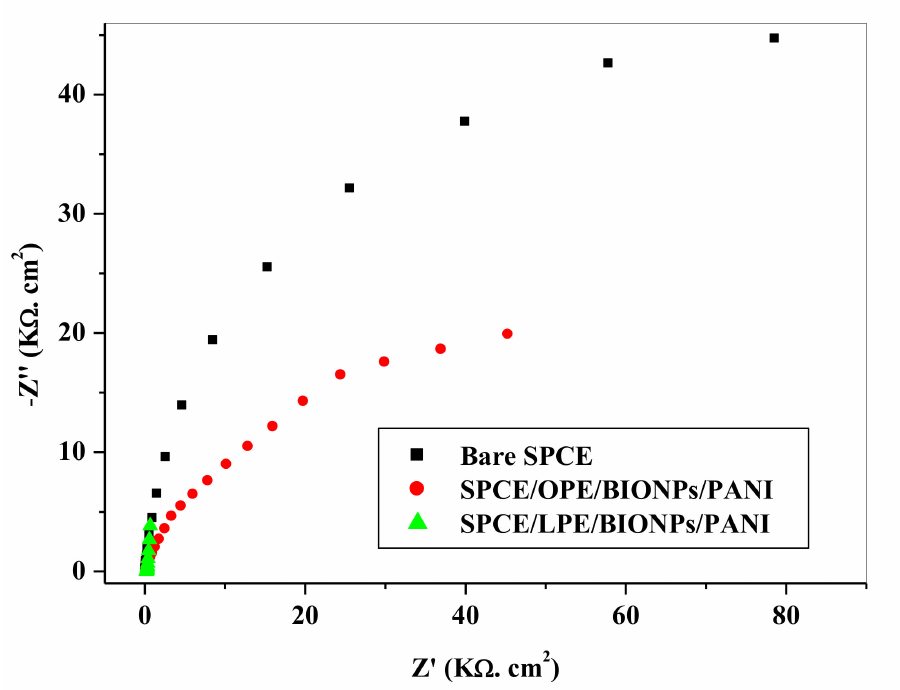
Figure 9. Electrochemical Impedance Spectroscopy of the Bare and the Modified